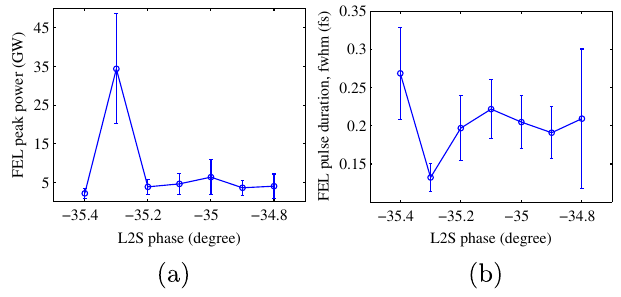
FIG. 11. FEL peak power (a) and pulse width (b) at 60 m in the undulator vs the L2 rf phase. The undulator is tapered at Δ K=K ¼ − 1% from 20 to 132 m.